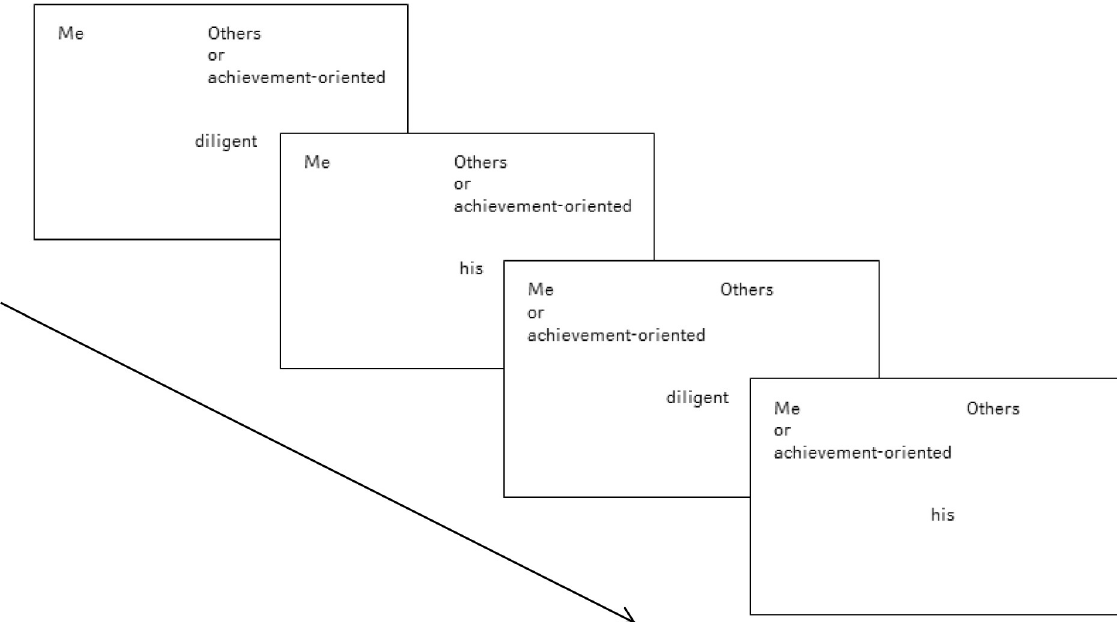
Fig 1. Examples of the four blocks of the perfectionism SC-IAT. In each block the attribute labels were presented and remained on the top left and top right corner of the screen, while the target category was presented on the top left in the one block and on the top right in the other block. The stimuli were displayed in the middle of the screen and had to be classified into the respective category.